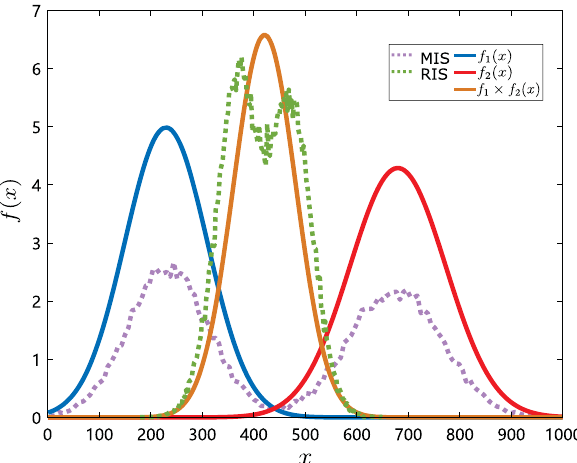
Fig. 10 Comparison between multiple importance sampling and RIS of the product of two functions f 1 and f 2 . RIS produces results much closer to the target product than MIS. Reproduced with permission from Ref. [42], c (cid:2) The Author(s)